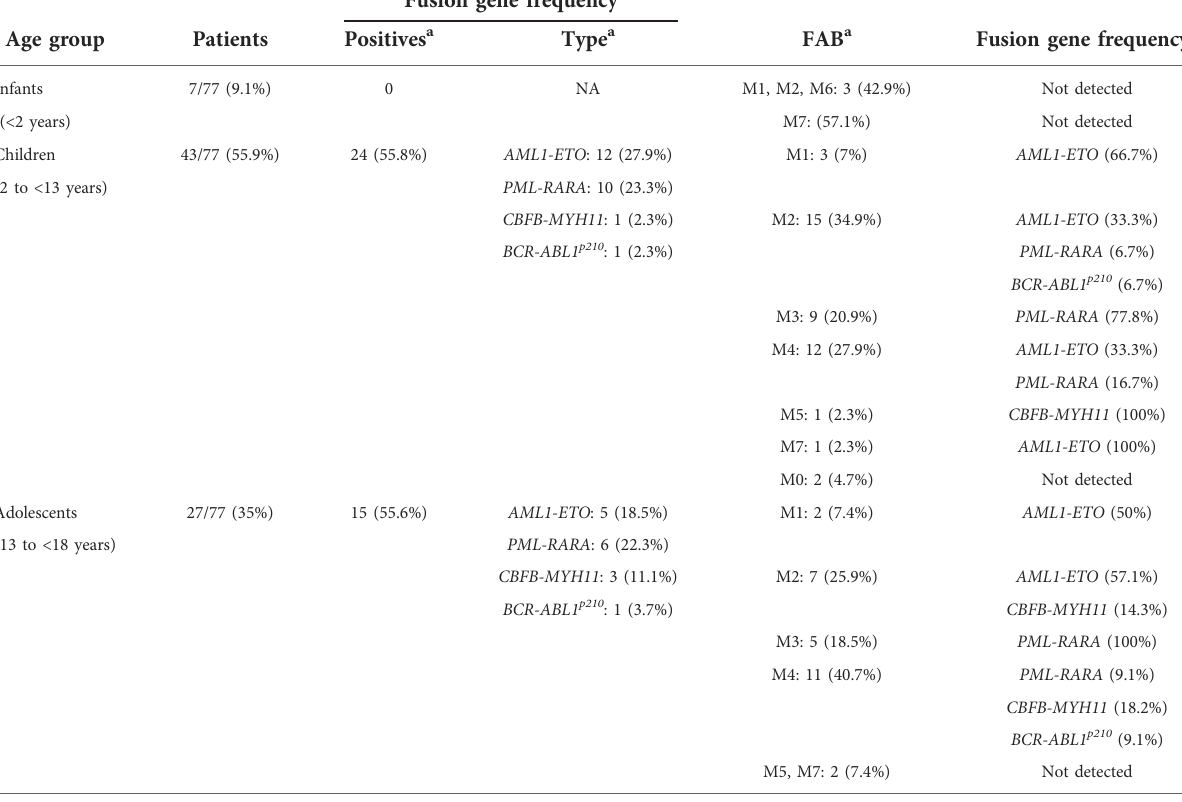
TABLE 3 Fusion gene frequencies in pediatric patients with acute myeloid leukemia according to age group and FAB